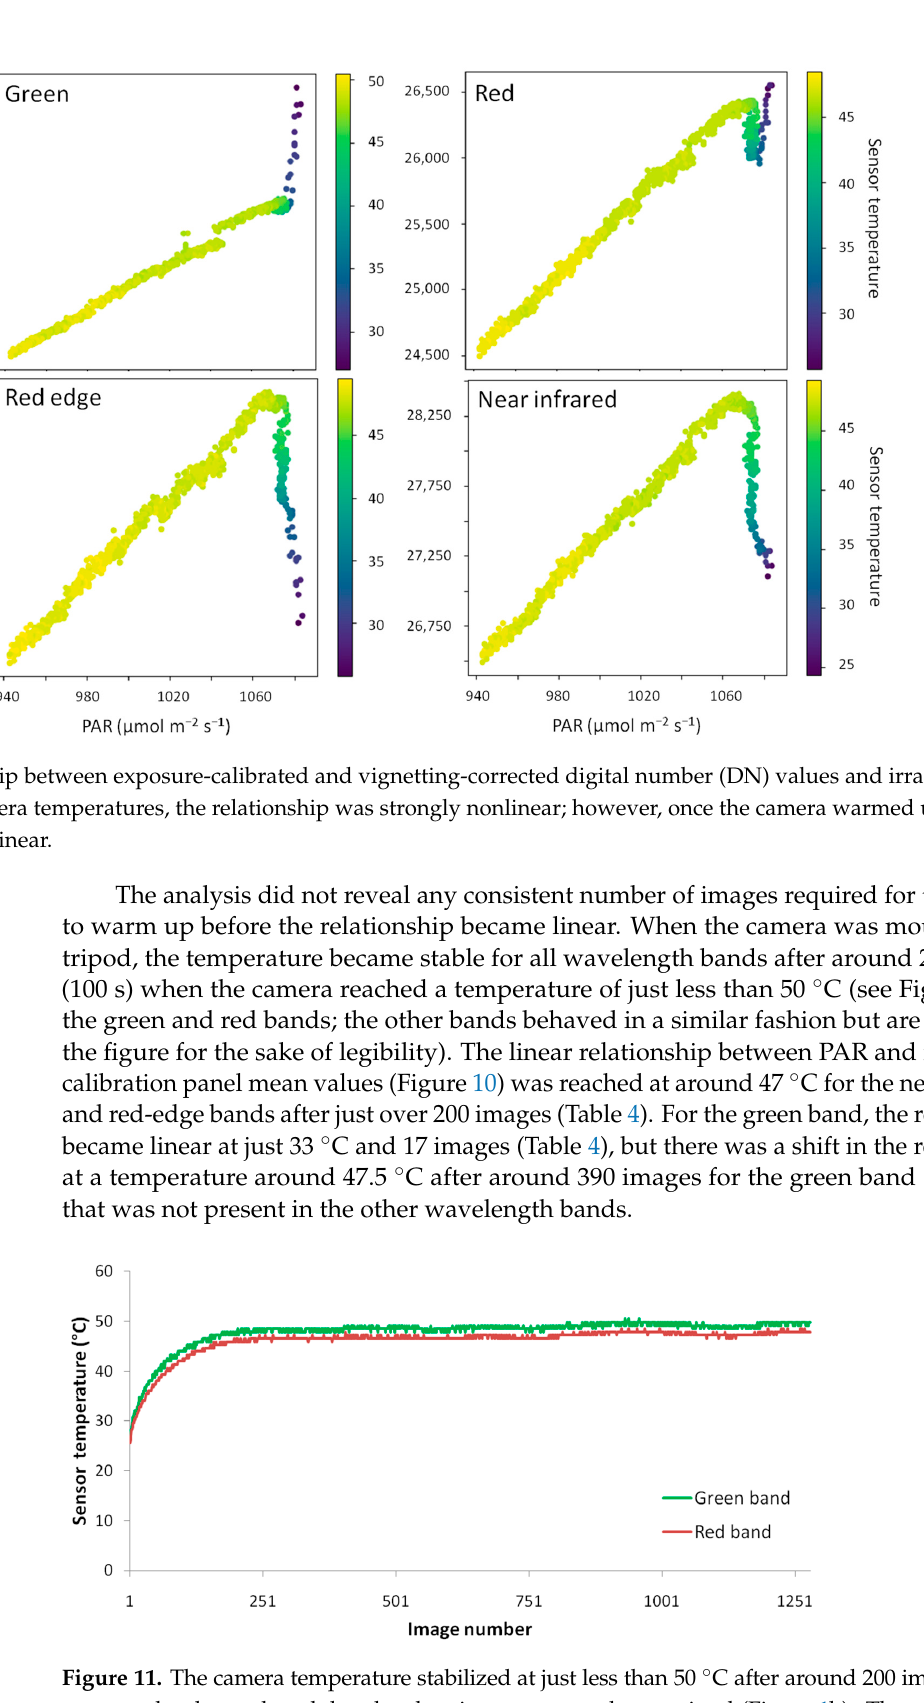
14 of 27 Figure 9. Roll, pitch, and yaw for the sunshine sensor during the flight at Lönnstorp on 22 Septem- ber 2020. 3.2. Influence of Camera Temperature on Sensor Corrected DN